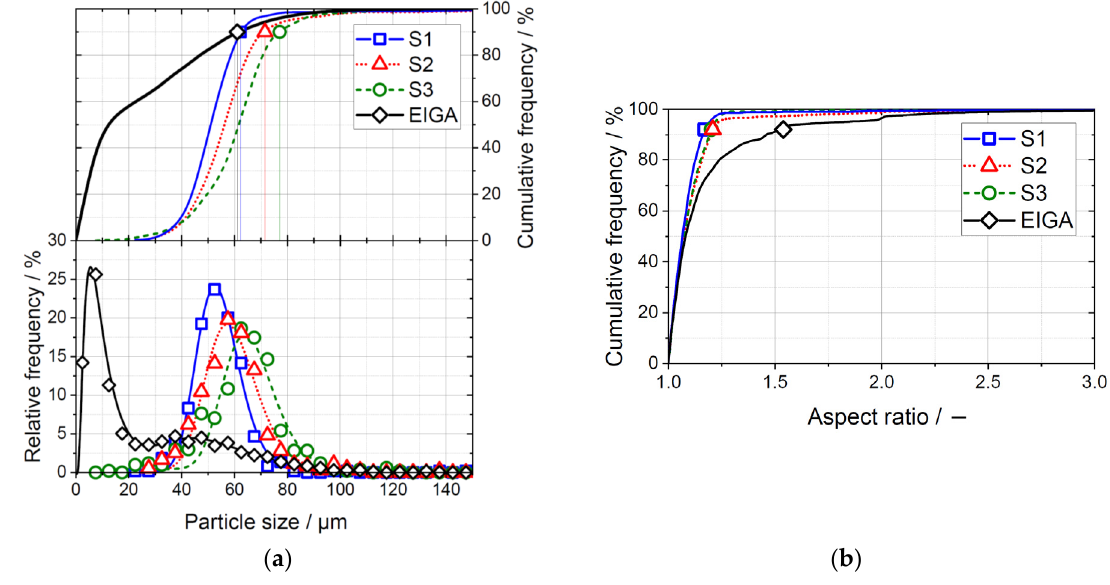
Figure 3. Particle size distribution ( a ) and aspect ratio distribution ( b ) of powders produced with UA (S1 to S3) and EIGA